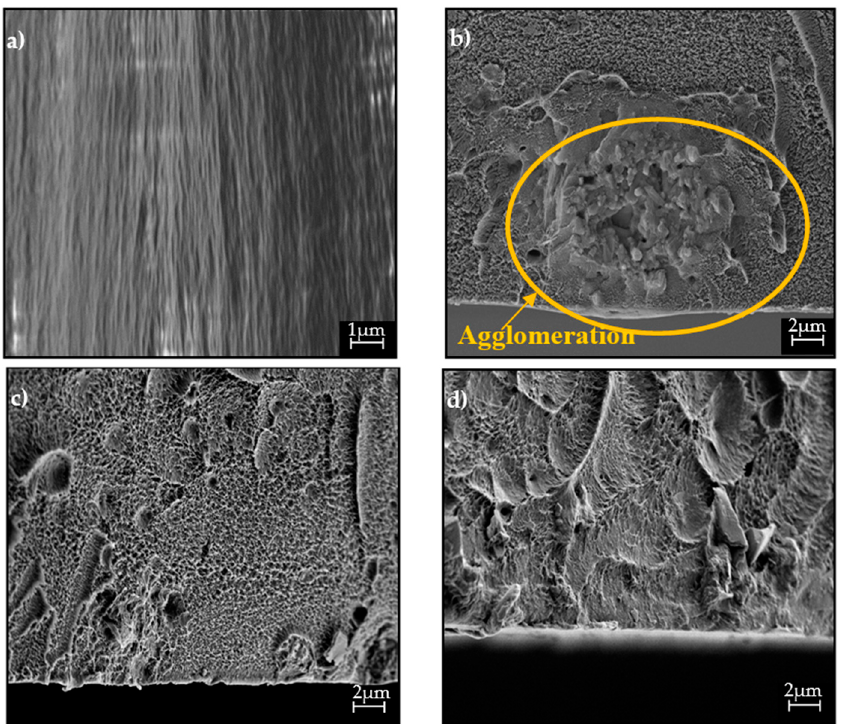
Figure 3. Cross-section images of ( a ) pure 6FDA-derived polyimide membrane, and impregnated Linde T ( b ) M1 ( c ) M2, and ( d ) M3 hybrid membranes.